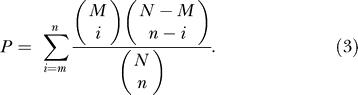
Functional Classification of SVGs in Three Microorganisms
M is the total number of genes in a COG broad functional category, and m is the number of SVGs within that category. r ( = m/M) is the proportion of SVGs in that category. The p-value is calculated using a hypergeometric distribution: let N = number of genes in the genome; n = number of SVGs identified; M = number of genes belonging to a particular category; m = number of SVGs belonging to a particular category:

The set of lineage-specific genes has been excluded in each genome to avoid the possible skew it brings to the estimation of significance. The significance level is set at 0.01. Cells with p-value less than 0.01 are shaded.